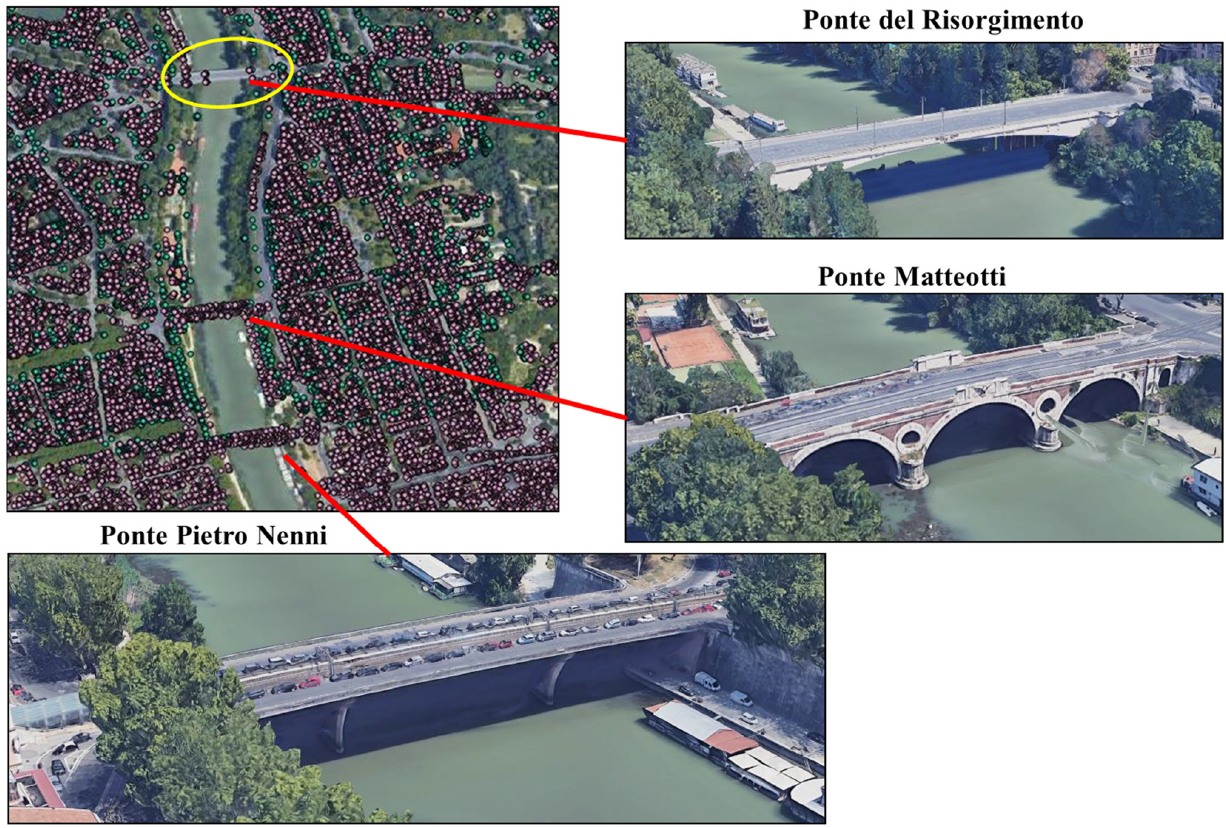
Figure 15. Measurement points detected by the satellite on the infrastructures located south of Ponte della Musica.